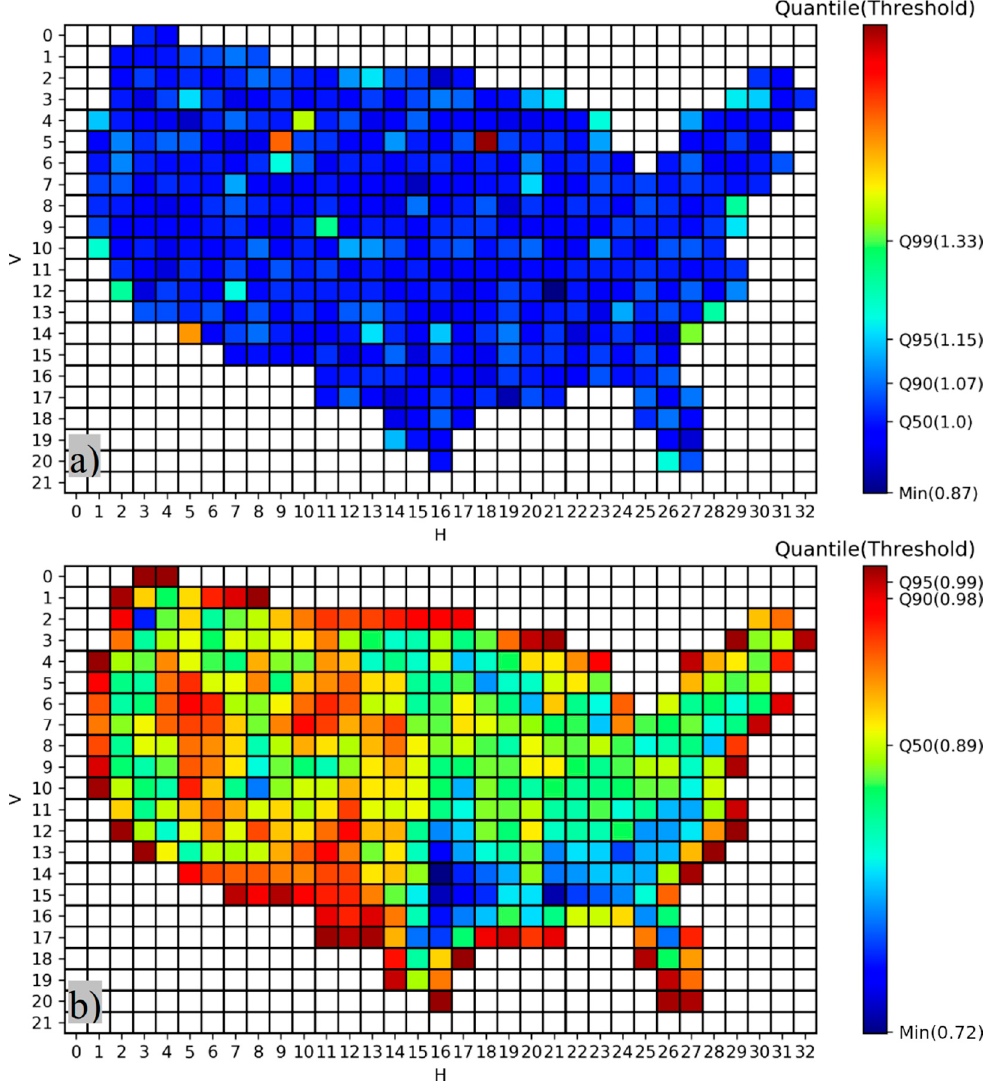
Figure 8. Illustration of outlier detection results for the final production (a). Panel (b) shows the lowest level of agreement between LCMAP and NLCD in 2001, 2006, or 2011. X and y axes show horizontal (H) and vertical (V) tile number, respectively. Table 4. Results of indices for H18V05 and its neighbor tiles.